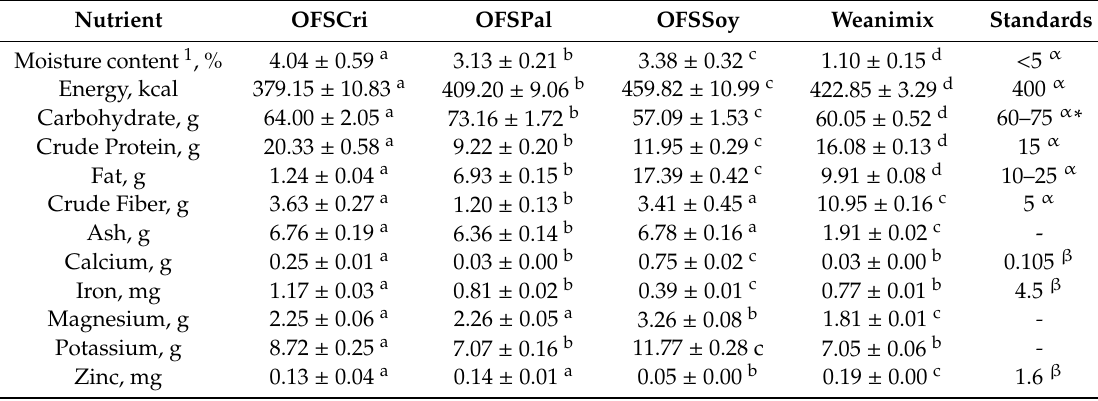
Table 2. Nutrient composition of orange-fleshed sweet potato based complementary foods and Weanimix on dry weight basis per 100 g. Nutrient OFSCri OFSPal